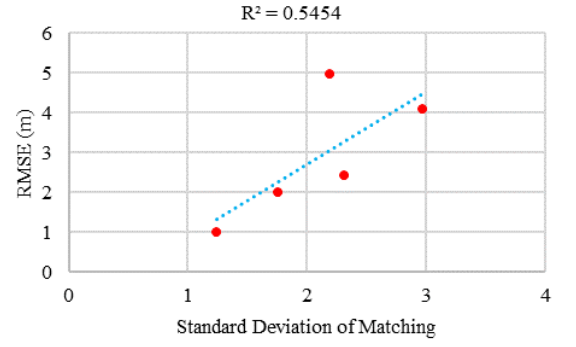
Figure 11. Cartosat-1 height errors: Correlation between RMSE of height residuals and mean value of standard deviation of stereo matching in different subsets